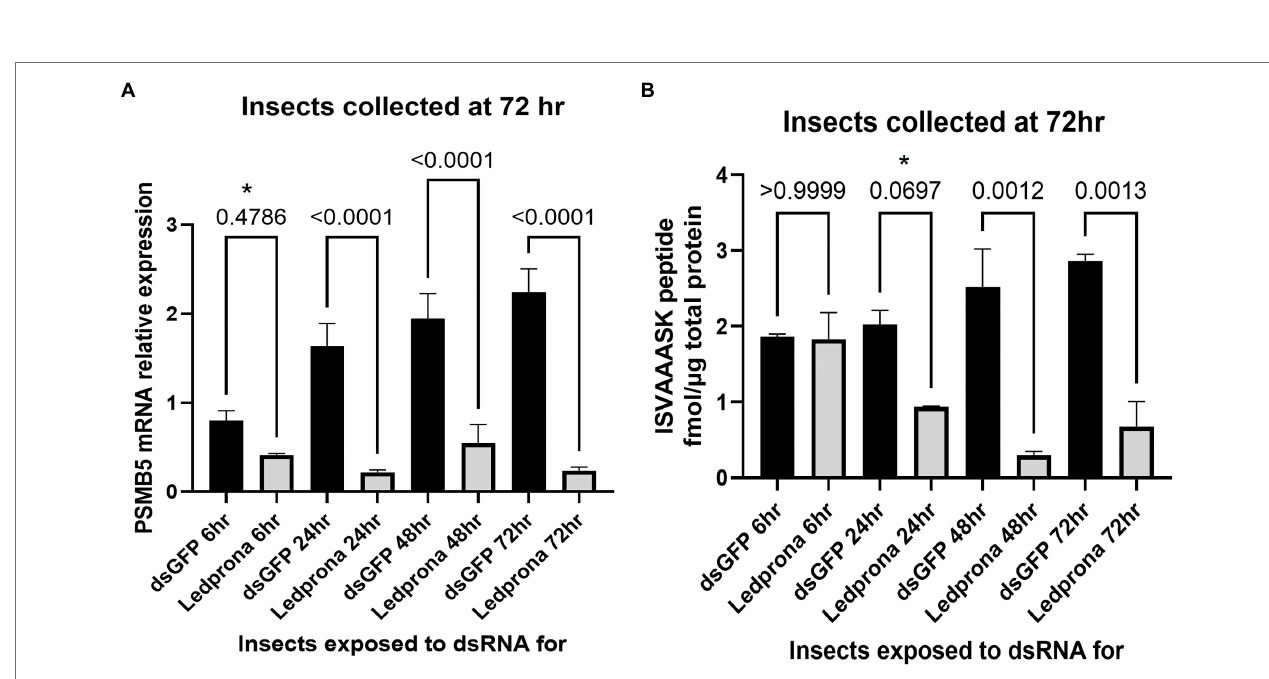
FIGURE 8 | PSMB5 mRNA relative expression (A) and protein level (B) of CPB larvae after different length of Ledprona exposure compared to dsGFP (control). Graph represents the average of biological replicates and error bars denote standard deviations. Values of p are indicated as a result of multiple comparison (Sidak’s multiple comparison test). Asterisks indicates the timepoints when differences among Ledprona and control were significant when considered alone [ t -test; (A) 6 h timepoint: value of p 0.0130; (B) 24 h timepoint: value of p